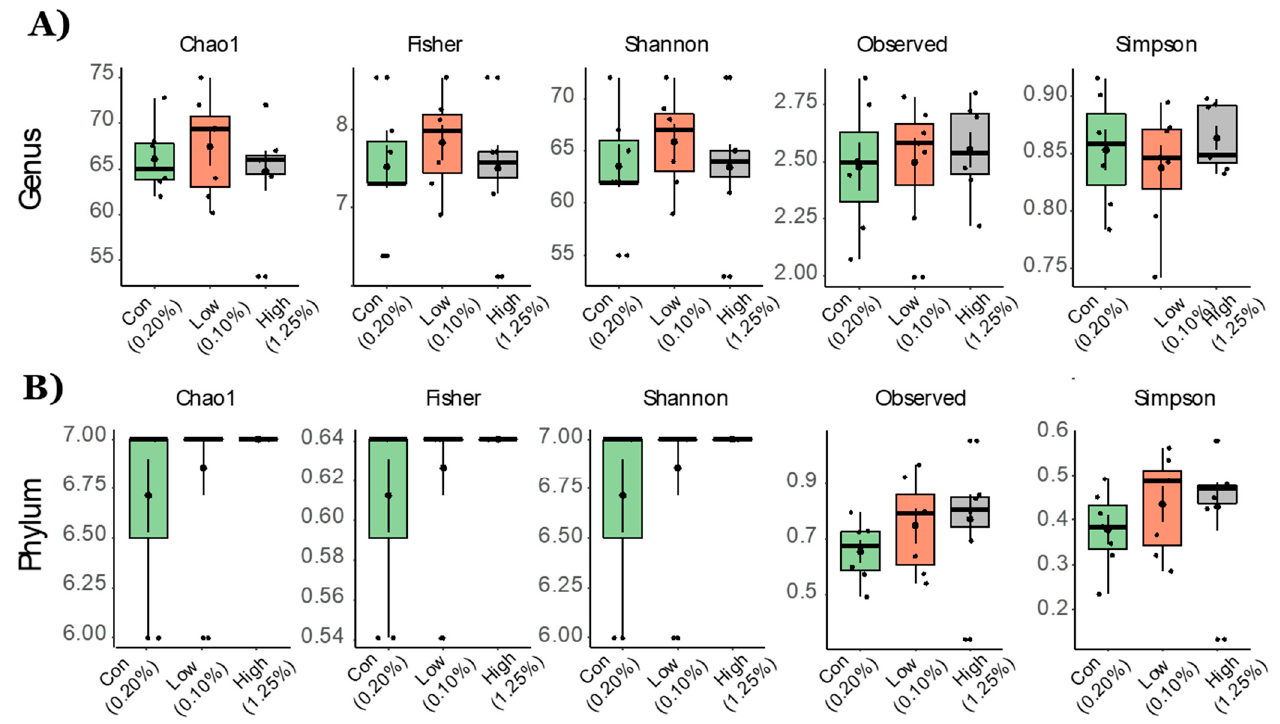
Figure 1. Alpha diversity measurements for aged mice fed with TRP-deficient and TRP-rich diets. α -diversity indices at the ( A ) genus and ( B ) phylum levels. Statistical differences between the group’s control diet ( n = 7), TRP-deficient diet ( n = 7), and TRP-rich diet ( n = 7) were determined by Kruskal Wallis one-way ANOVA for doses of TRP. Data are expressed as mean ± SE and all comparisons at all indices were non-significant.